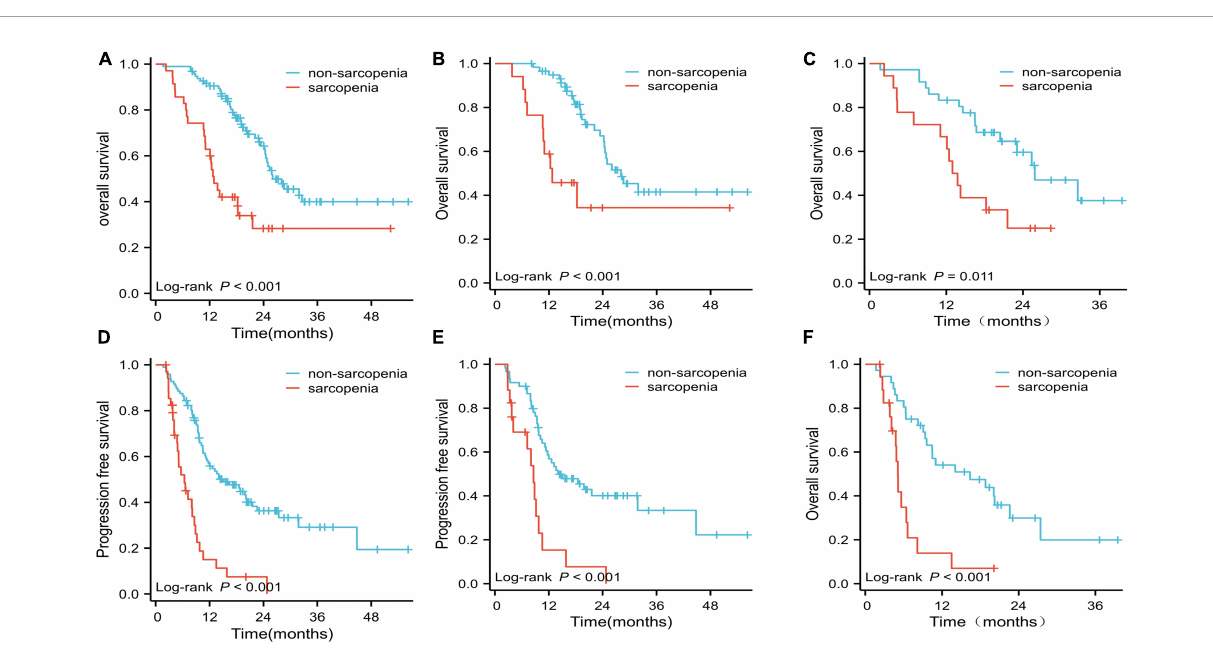
of AEs was established using the exact Fisher test and χ 2